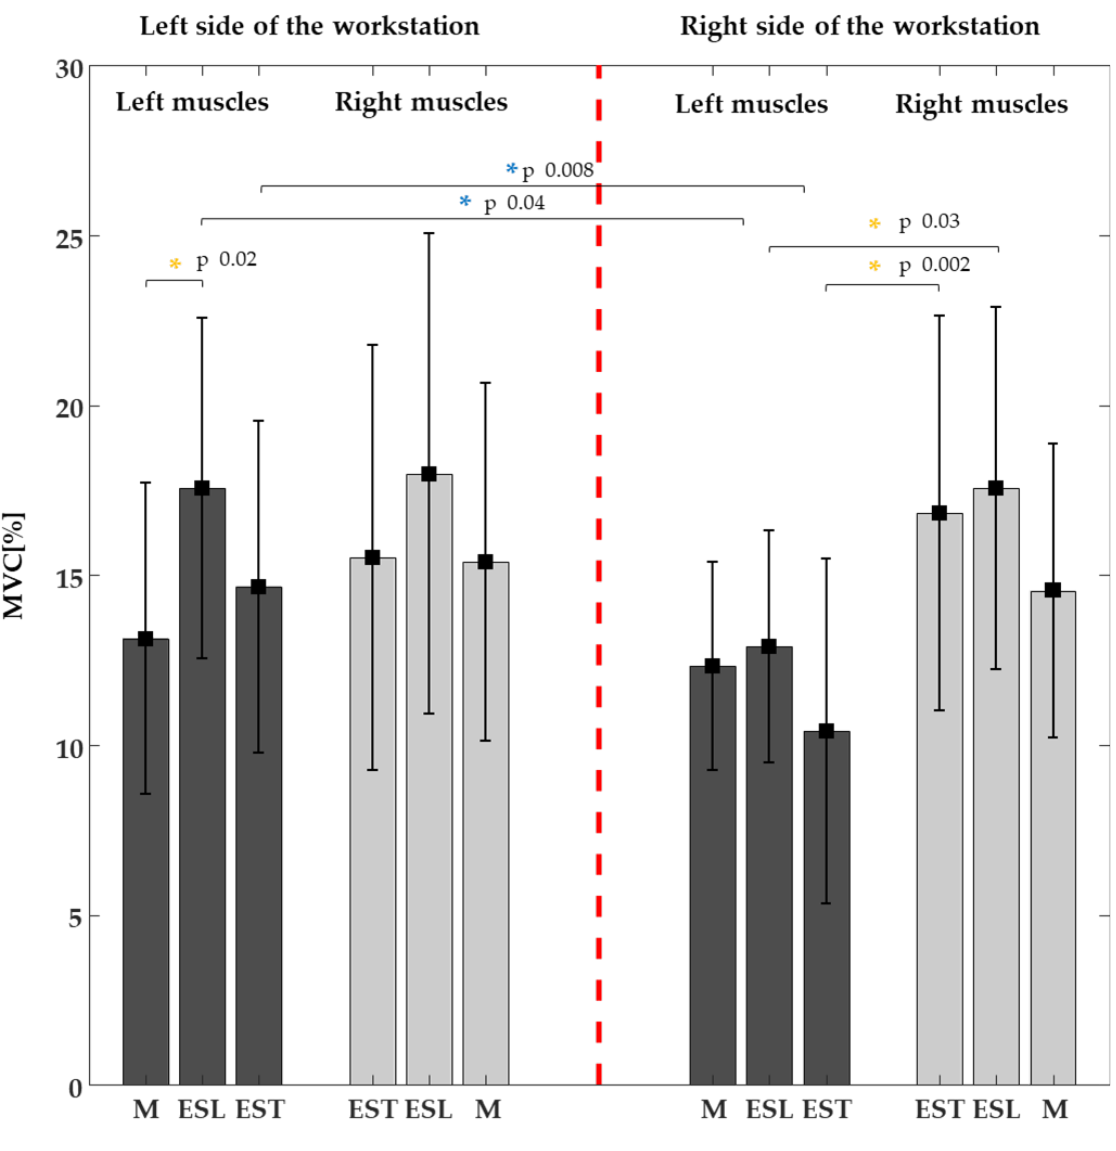
Figure 7. Muscle activity average values of overall paravertebral muscles (M—Multifidus; EST—Erector Spinae Thoracic region; ESL—Erector Spinae Lumbar region). The comparison between the right and left side of the workstation (BLUE stars across the two sides of the workstation) and between the right and left muscles of the same side of the workstation (YELLOW stars on the same side of the workstation) show a statistical difference in the activation among the different muscle groups (* p value).